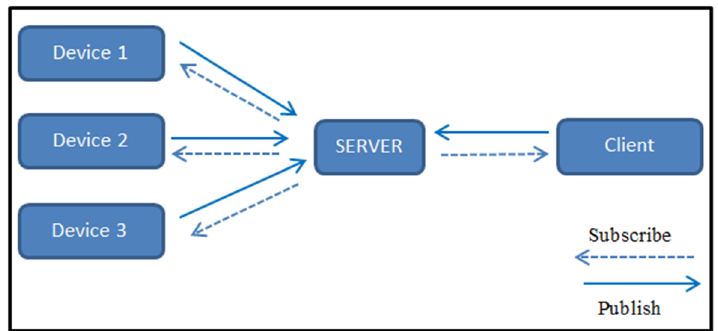
Figure 4. MQTT flow diagram .